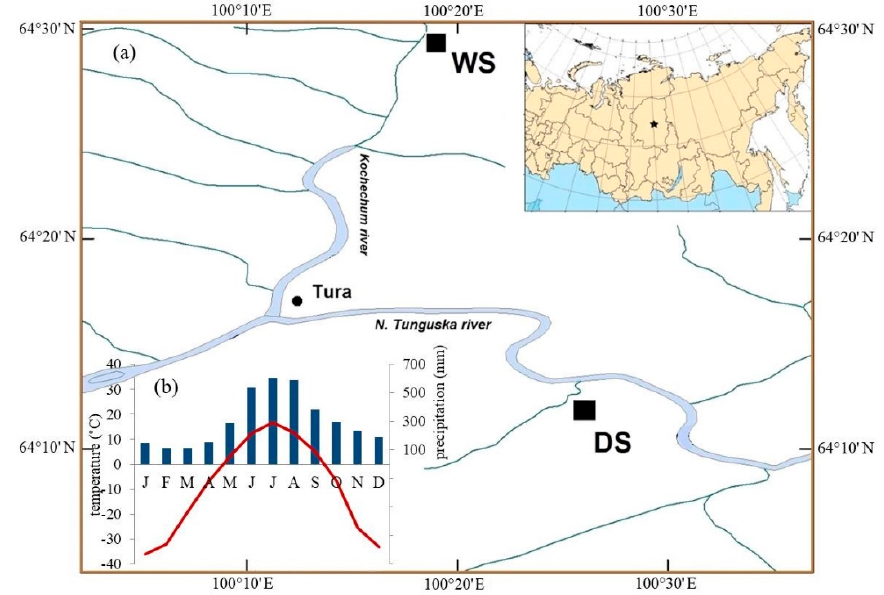
Figure 1. Map of the study sites (WS—wet site; DS—dry site) ( a ) and diagram with the main climatic characteristics of the study region Tura ( b ) (average values of precipitation (columns) and monthly mean temperature (line)) from the meteorological station Tura (1936 − 2010).